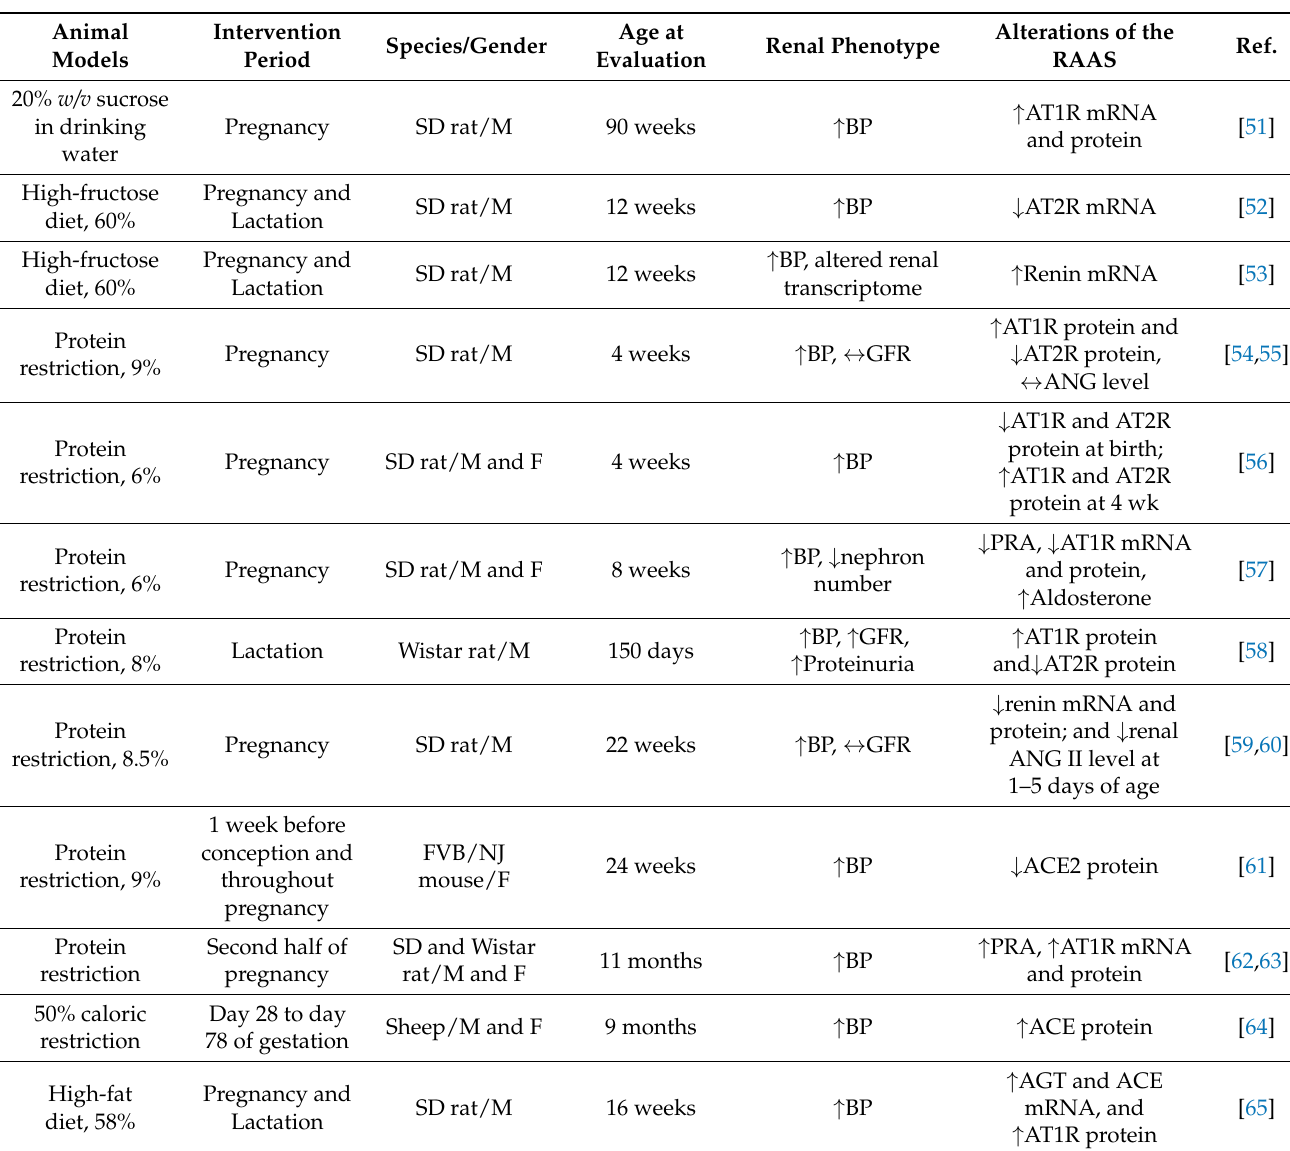
Table 1. Renal programming related to aberrant renin-angiotensin-aldosterone system (RAAS) in animal models. Studies tabulated according to animal models, species, and age at evaluation. CKD, chronic kidney disease; L-NAME, L-N G - Nitro arginine methyl ester; LPS, lipopolysaccharide; TCDD, 2,3,7,8-tetrachlorodibenzo-p-dioxin; PDTC, pyrrolidine dithiocarbamate; DEX, dexamethasone; Cr, creatinine; SD, Sprague Dawley; SHR, spontaneously hypertensive rat; M, male; F, female; BP, blood pressure; GFR, glomerular filtration rate; ↑ , increased; ↓ , decreased; ↔ , unaltered; PRR, (pro)renin receptor; PRA, plasma renin activity; ACE, angiotensin-converting enzyme; ACE2, angiotensin-converting enzyme 2; AGT, angiotensinogen; AT1R, angiotensin type 1 receptor; AT2R, angiotensin type 2 receptor.